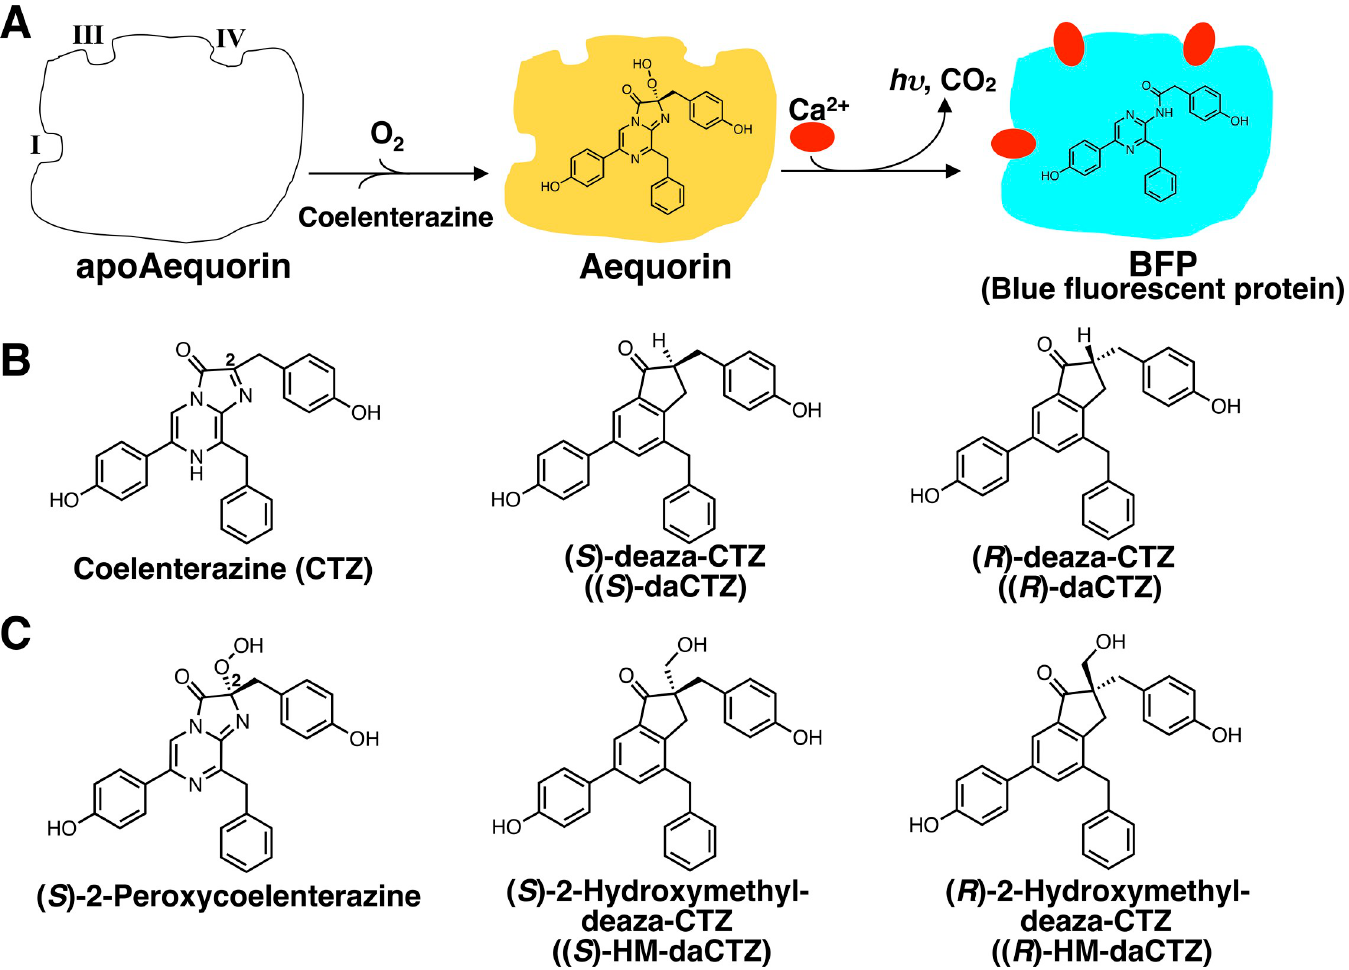
Fig 3. Ca 2+ -triggered luminescence reaction of aequorin, regenerated from apoAequorin and coelenterazine. A. Regeneration of aequorin from apoAequorin and coelenterazine, followed by the calcium triggered-luminescence reaction. B. Structures of coelenterazine (CTZ) and its chiral deaza-analogs of ( S )- and ( R )-deaza-CTZ (daCTZ). C. Structures of ( S )-2-peroxycoelenterazine and the chiral deaza-analogs of ( S )-2- and ( R )-2-hydroxymethyl-deaza-CTZ (HM-daCTZ).